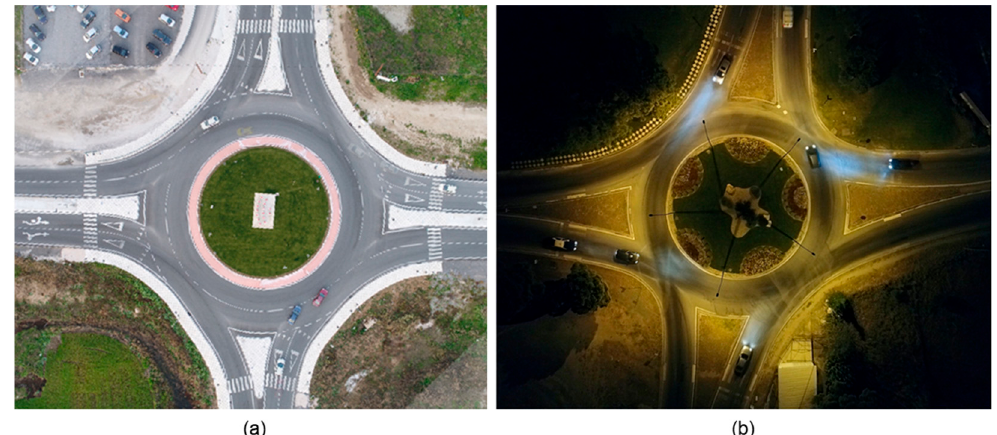
Figure 5. UAV shot of the examined case studies: ( a ) Larissa and ( b ) Thessaloniki .